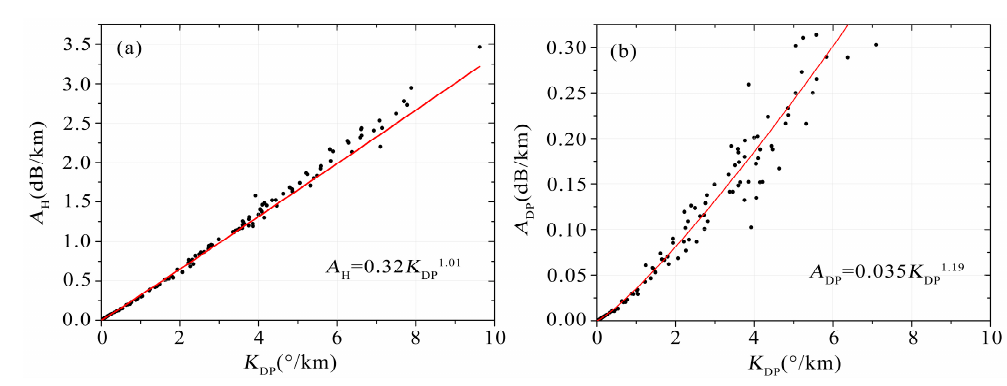
Figure 4. The K DP - A H (a) and K DP - A DP (b) relationships for the X-band PAR fitted by DSD data.